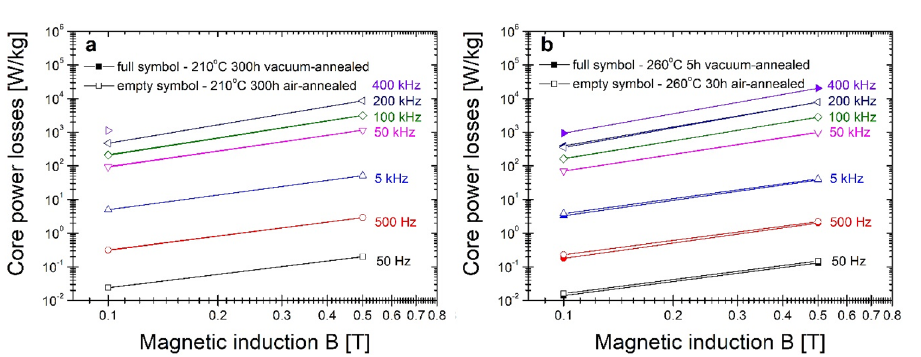
Figure 12. Core power losses in the function of magnetic induction for annealed metallic ribbons at ( a ) 210 °C and ( b ) 260 °C.